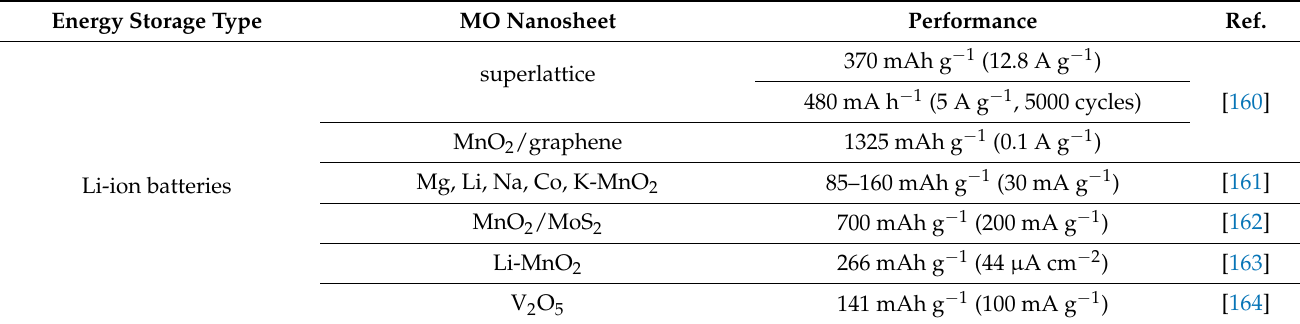
Table 4. Applications of several MO nanosheets in different EES